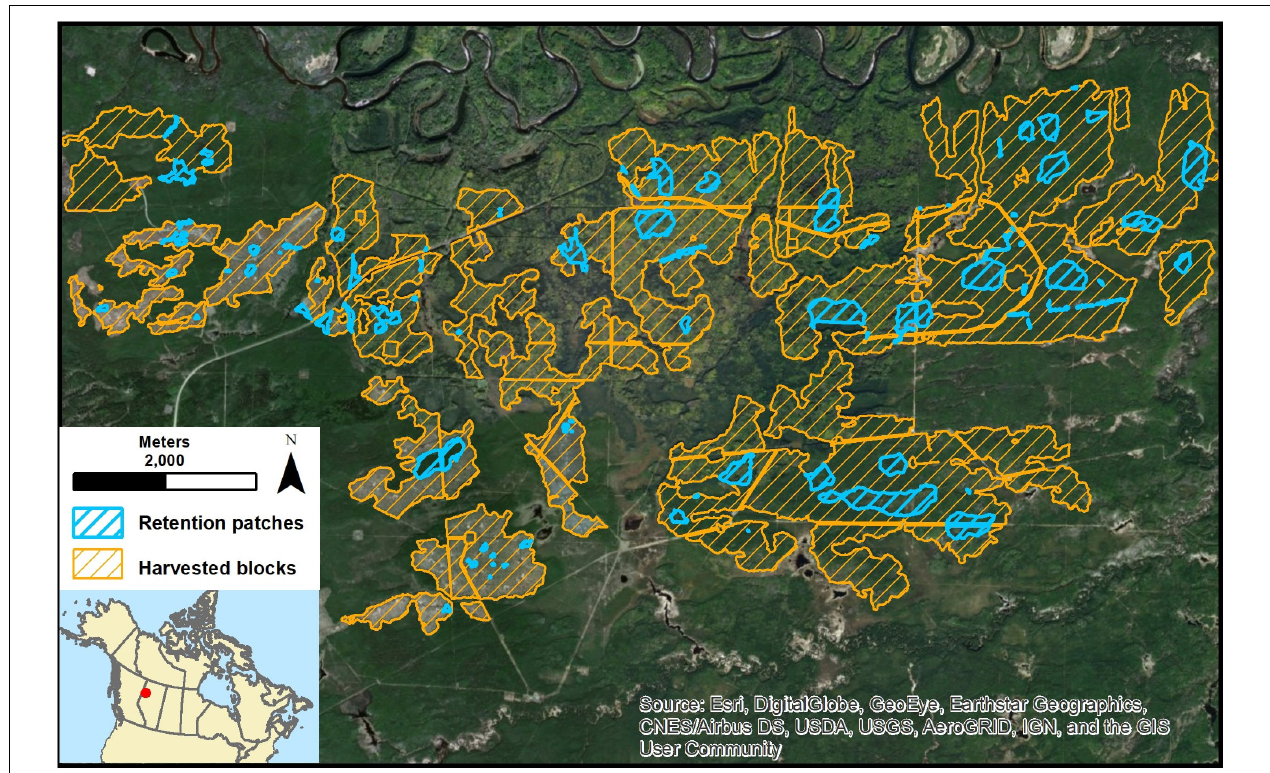
FIGURE 1 | Study area located in northwestern Alberta, Canada (118 ◦ 15 (cid:48) W, 56 ◦ 52 (cid:48) N). The map displays forested perimeters that were harvested or are planned to be harvested, as well as existing and planned retention perimeters. The modeling work and analysis presented in this study apply to these perimeters only.